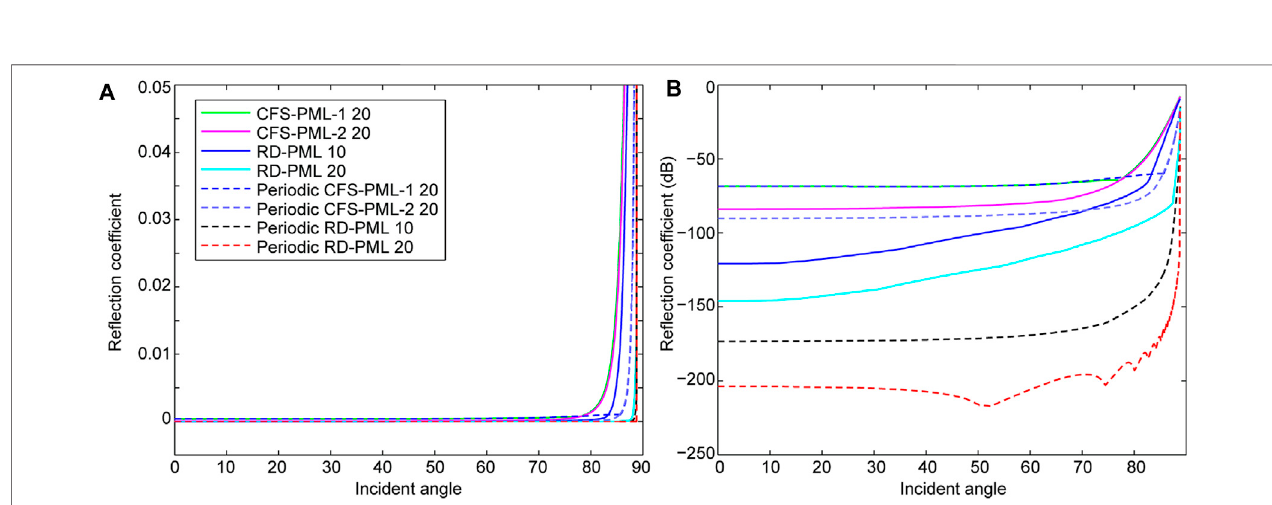
FIGURE9| Comparisonofthere fl ectioncoef fi cientcomputedbynumericalsimulations. (A) Absolutevaluesofnumericalre fl ectioncoef fi cient. (B) Thedecibel(dB) values of numerical re fl ection coef fi cient.